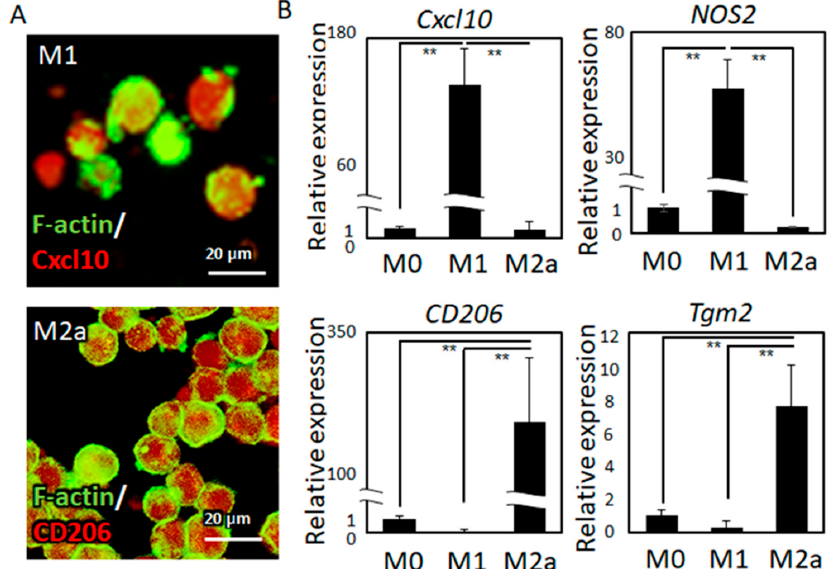
Figure 2. ( A ) Immunocytochemical analysis of Cxcl10 and CD206 marker expression in M1- and M2-